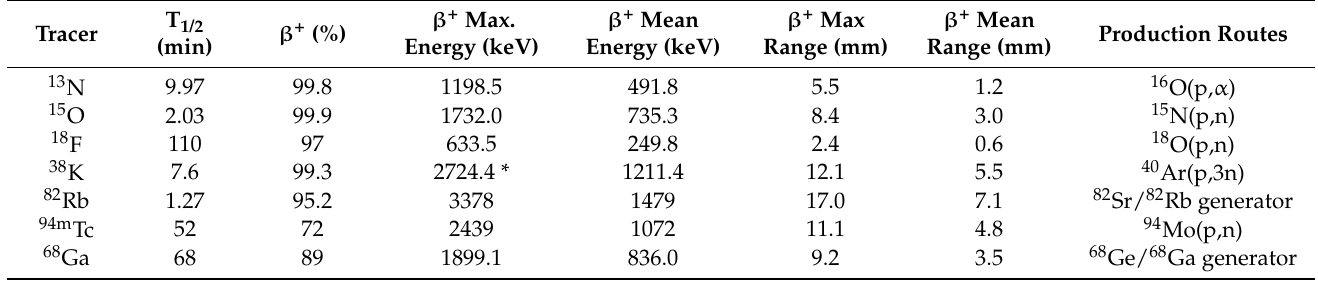
Table 1. PET tracers investigated for blood pool imaging (taken from Conti and Eriksson